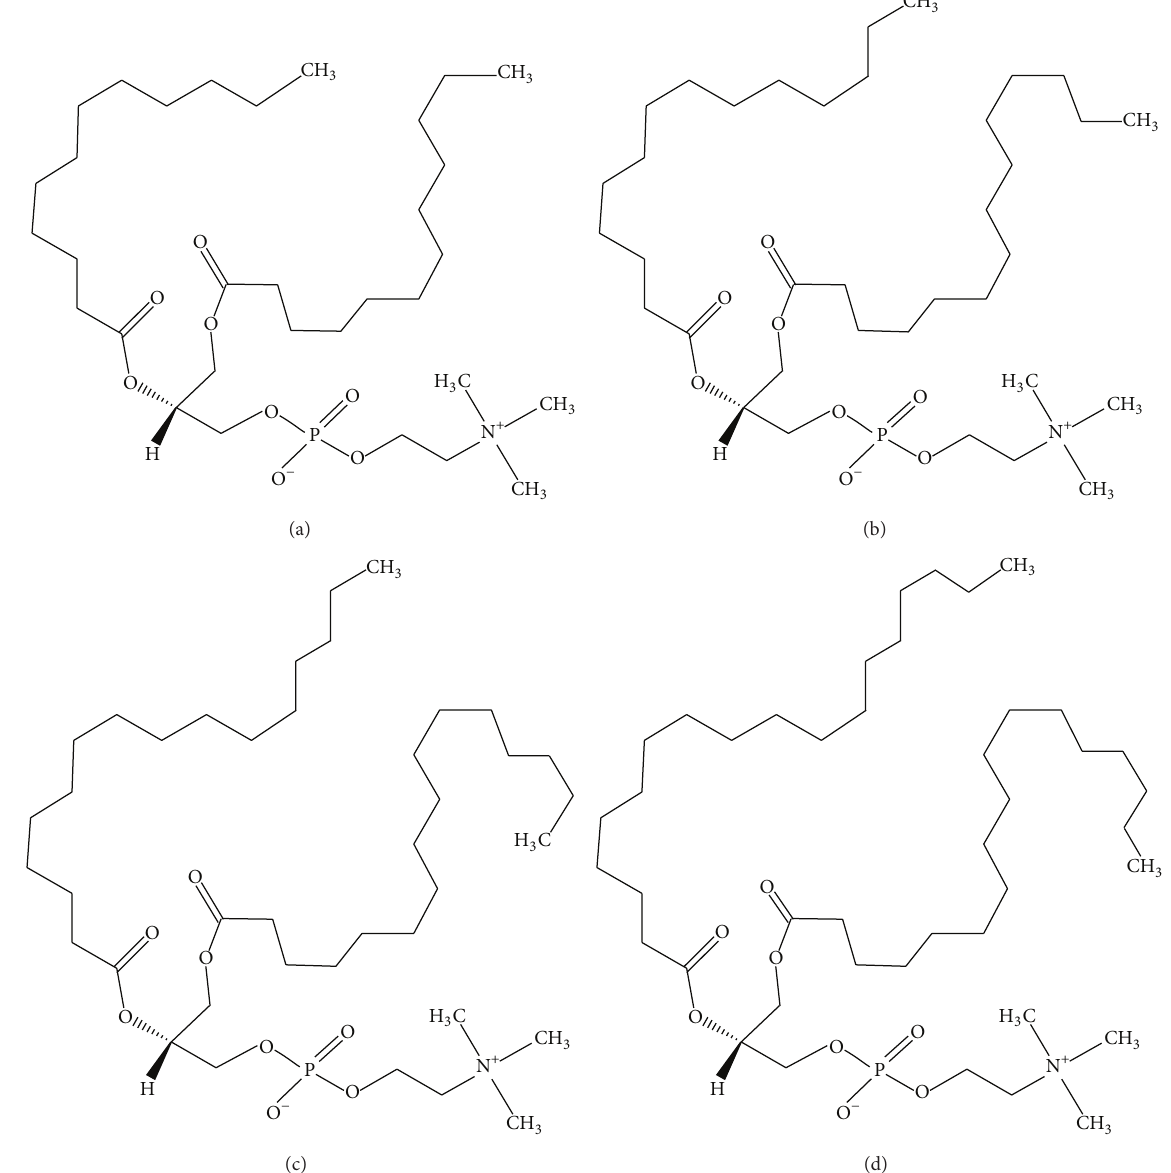
Figure 1: The structures of DLPC, DMPC, DPPC, and DSPC